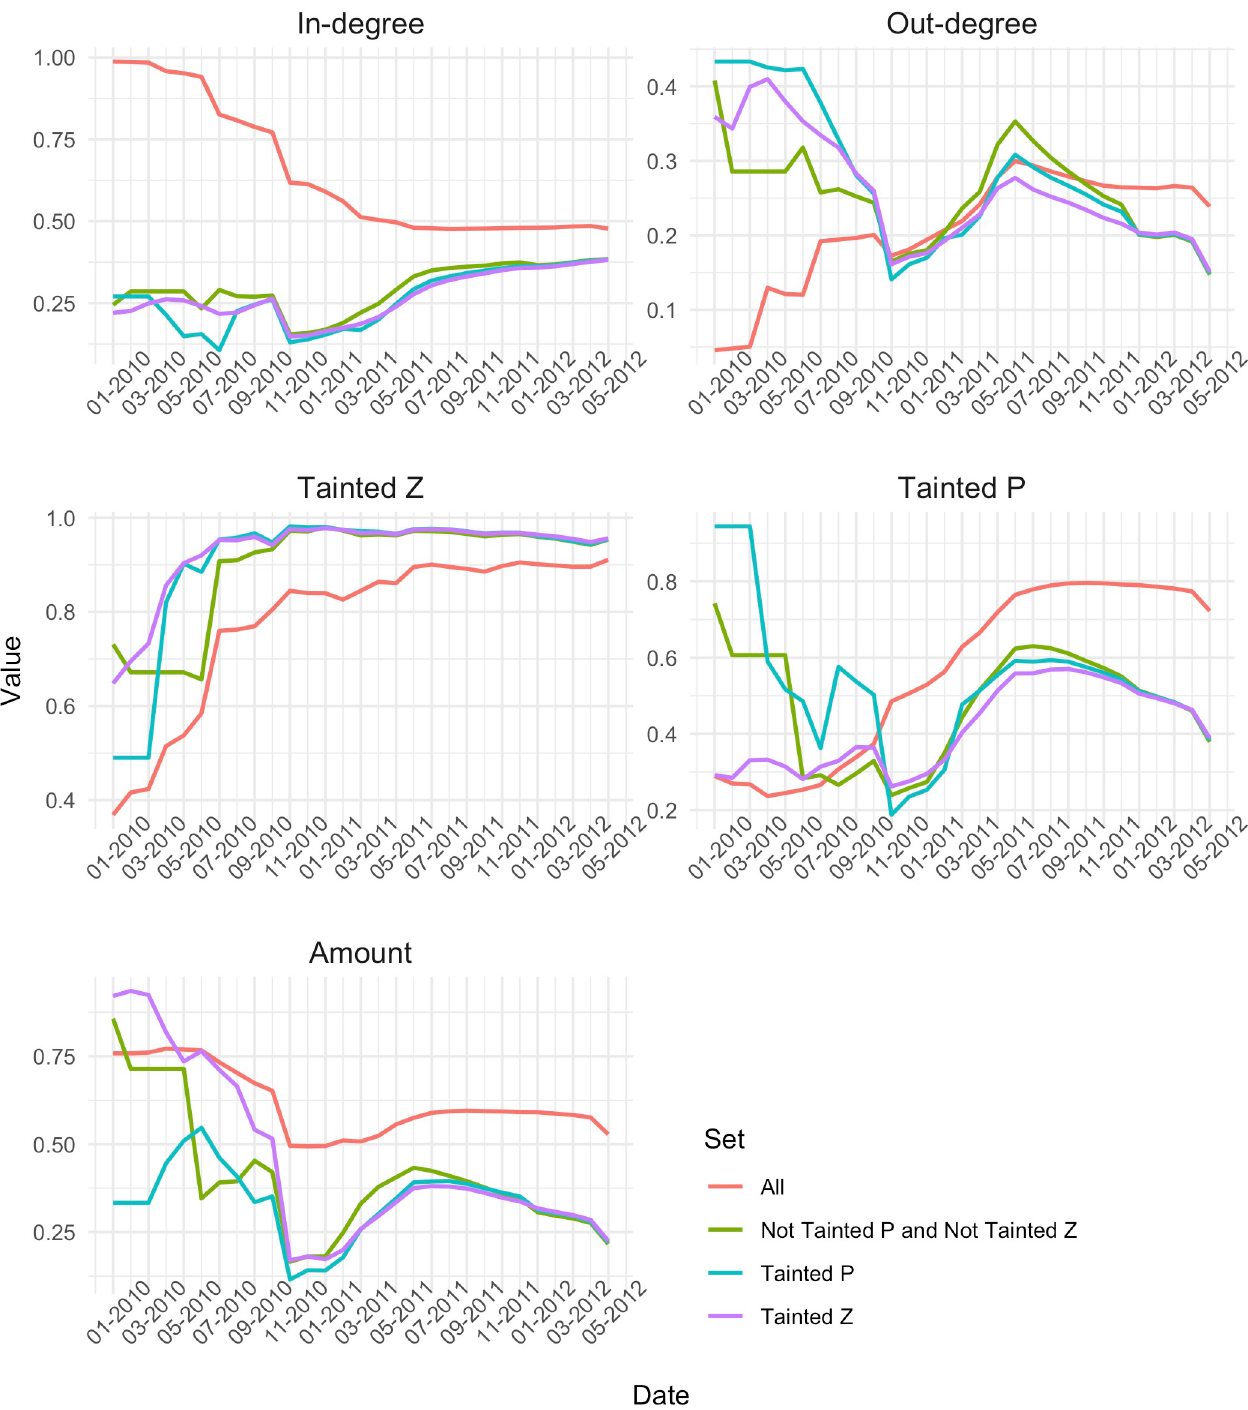
Fig 3. Evolution of Gini coefficients of in-degree, out-degree, tainted Z ratio, tainted P ratio and transaction amount, for the all transaction network and three sub-networks.